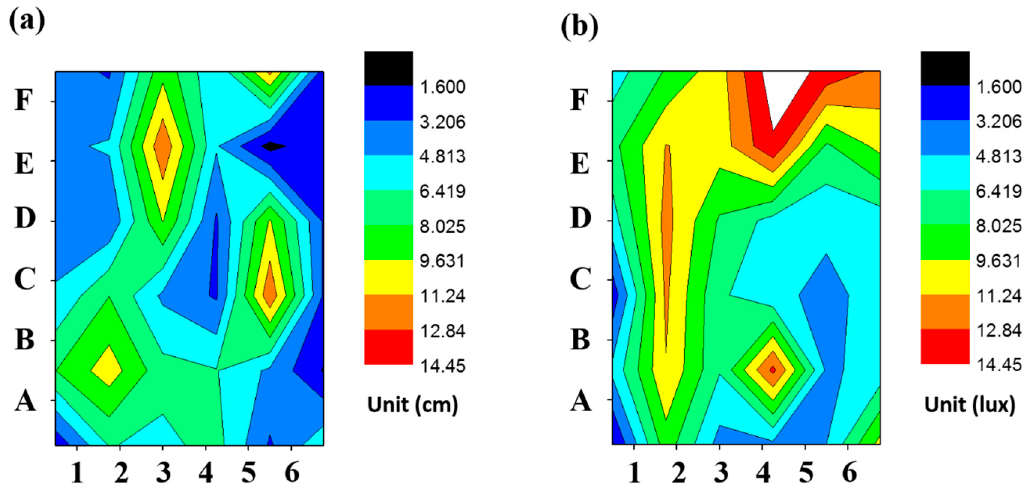
Figure 5. 2D distribution of ( a ) growth of water bamboo leaves and ( b ) light intensity measured in the field of water bamboo leaves.